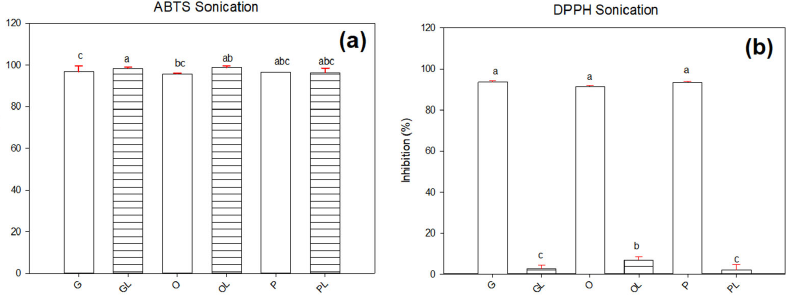
Figure 2. Radical inhibition in native oils and oils with lycopene by sonication technique using ABTS radical ( a ) and ( b ) DPPH radical. Letters (a–c) represent significant differences between samples.